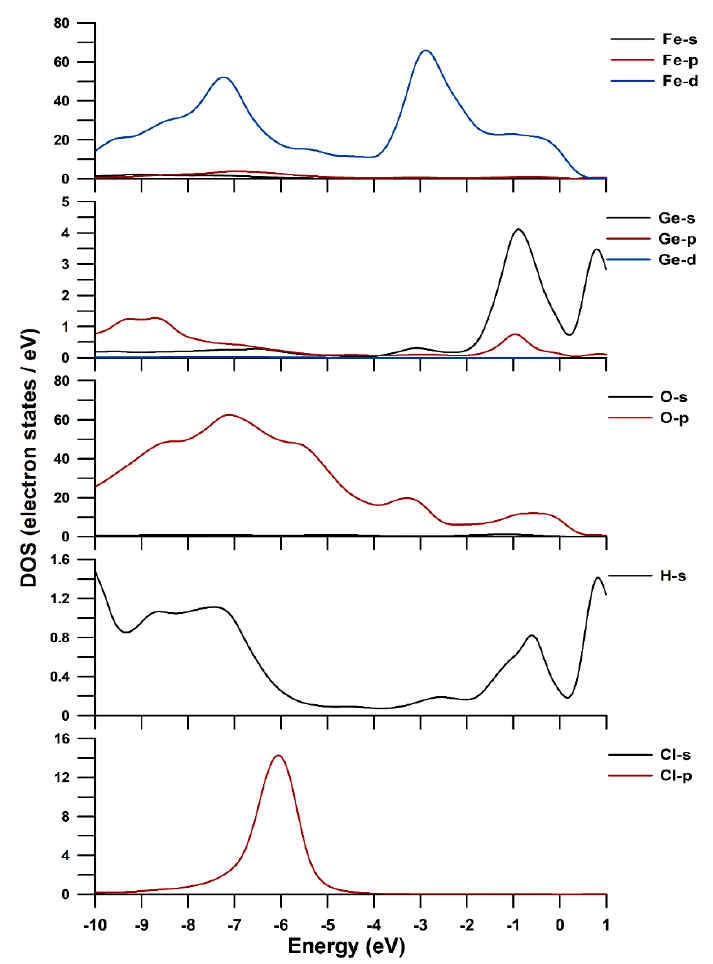
Figure 6. Partial density of states for the Ge ‐ akaganéite model, calculated within the GGA. Outer ‐ electron states of Fe(3d,4s,4p), Ge(3d,4s,4p), O(2s,2p), H(1s) and Cl(3s,3p), shell electron states of Fe(3d,4s,4p), Ge(3d,4s,4p), O(2s,2p), H(1s) and Cl(3s,3p), respectively.